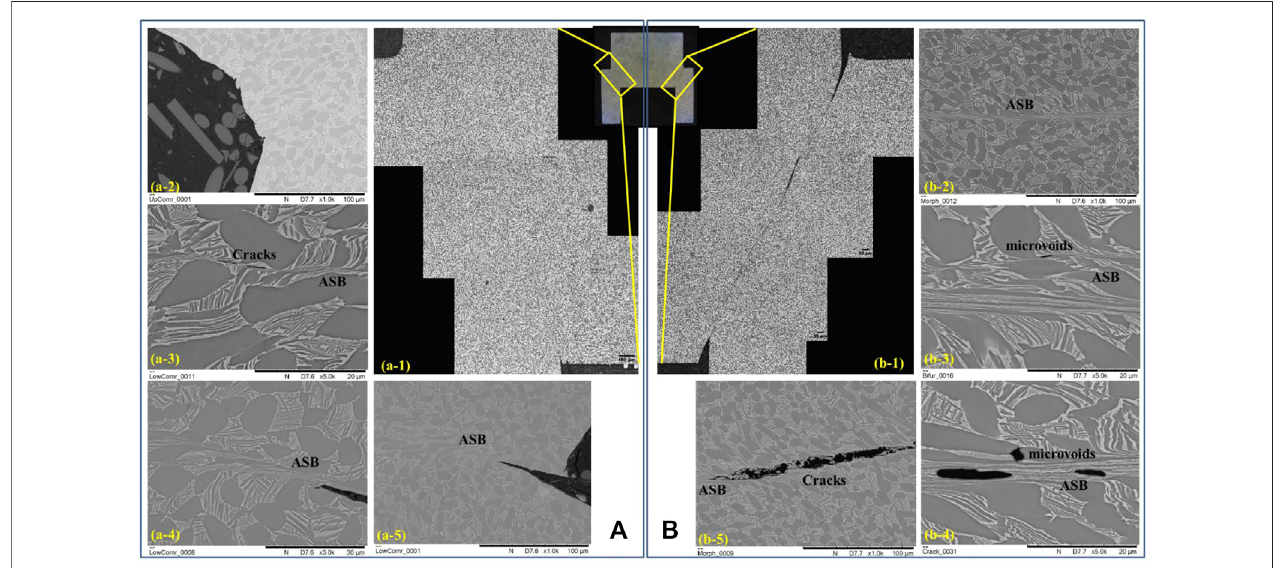
FIGURE4| Themulti-scalesSEMcharacterizationsofadiabaticshearbandsinthehat-shapedspecimenatstrainrateof1.8×10 4 s − 1 (Haoetal.,2021), (A) theleft part; (B) the right part. The additional numbers identify the typical features of selected regions.